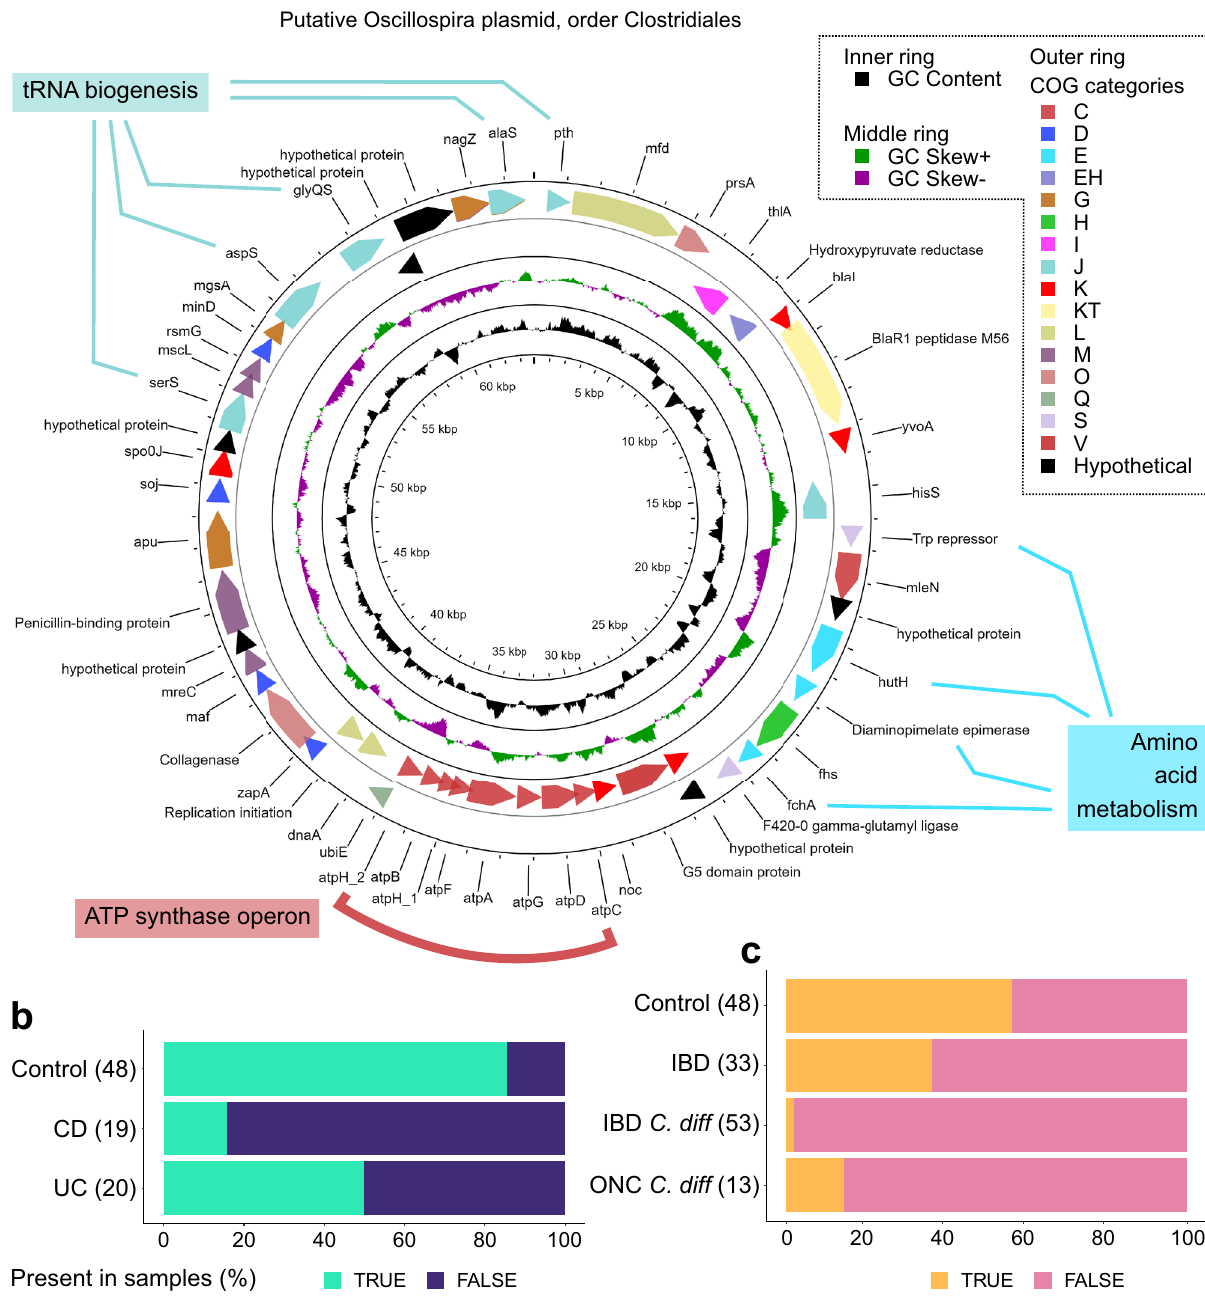
Figure 6. Human microbiome plasmids as biomarkers of gut health. ( a ) Genetic map of putative Oscillospira plasmid, NODE_195_length_63930_cov_13.4714_ID_24111 (pSRS_001). In addition to diverse functions, pSRS_001 encodes amino acid synthesis and metabolism genes, and a full F-type ATP synthase operon. Presence of plasmid pSRS_001 in the microbiome of ( b ) adult control, CD, and UC cohorts, and ( c ) paediatric control, IBD, IBD with C. difficile , and malignancy (ONC) with C. difficile